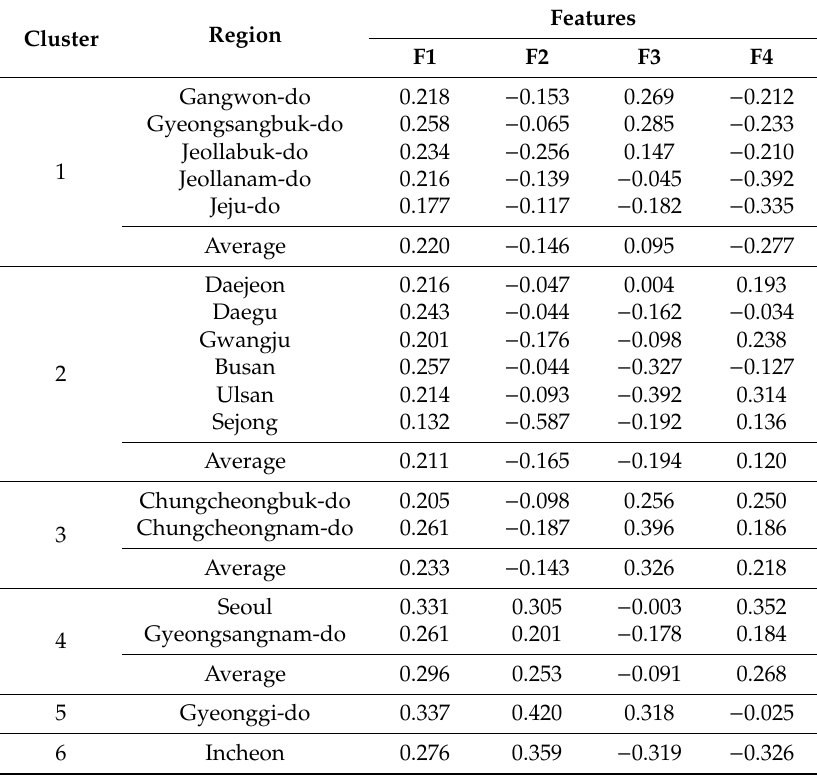
Table 4. Extracted features of the